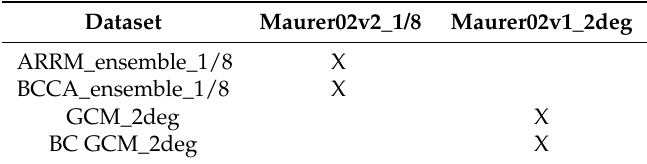
Table 3. Comparisons performed between model derived data and observed